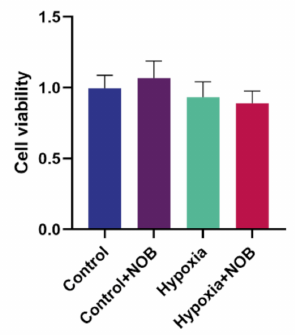
Figure 7. Cell viability of astrocytes treated with or without 1 µ m NOB under normal conditions and hypoxic conditions by the CCK-8 assay. The data are shown as mean ± SD, n =